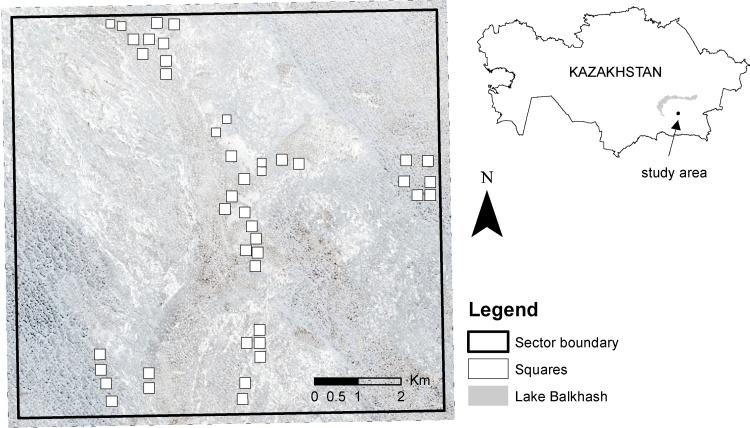
Study area in Eastern Kazakhstan. The 38 field data-collection squares are shown, all located within one sector and projected on WorldView-2 image (DigitalGlobe, 2014).